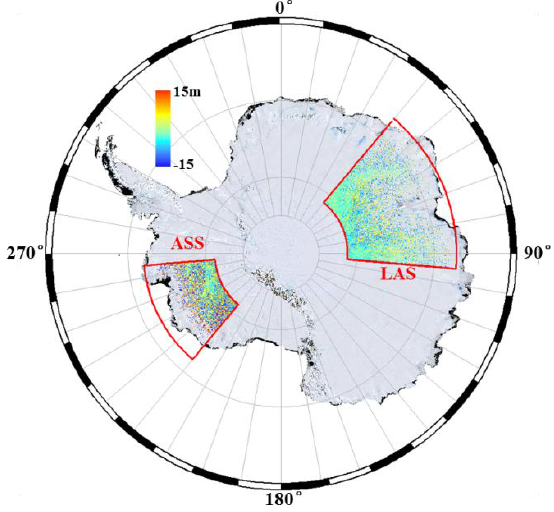
Figure 3. the deviation of ICESat-Envisat The deviation of ICESat-Envisat is shown in figure 3. As the figure shows, the flatter inner area of Antarctic ice sheet has a small deviation than complex margin area in both ASS and